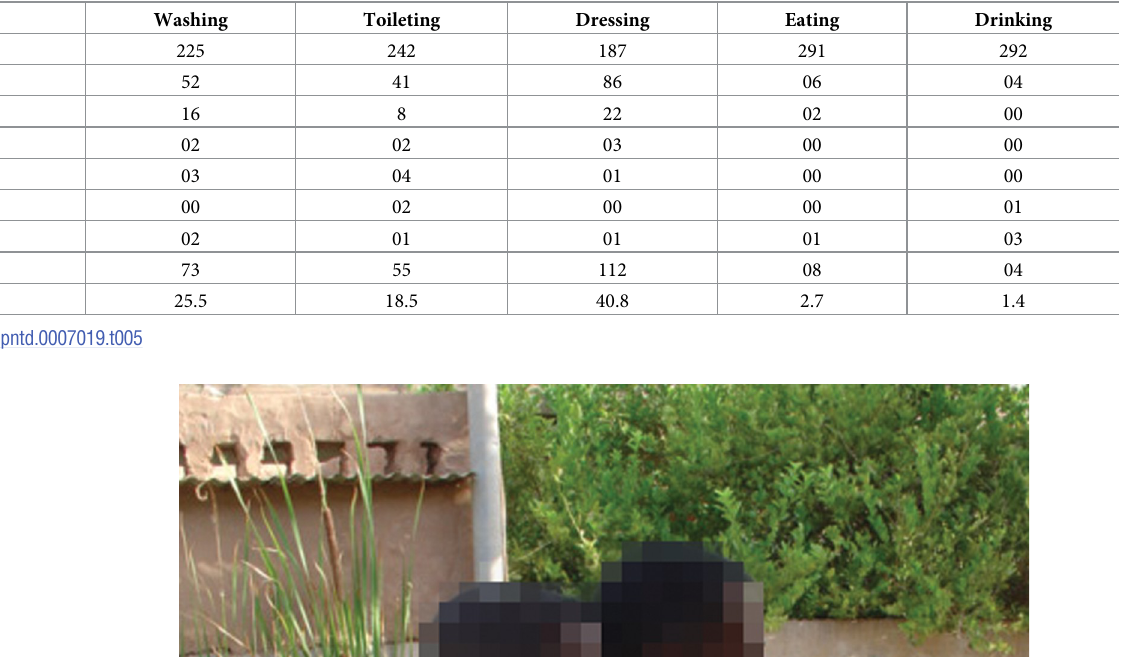
Table 5. Difficulties in self care.